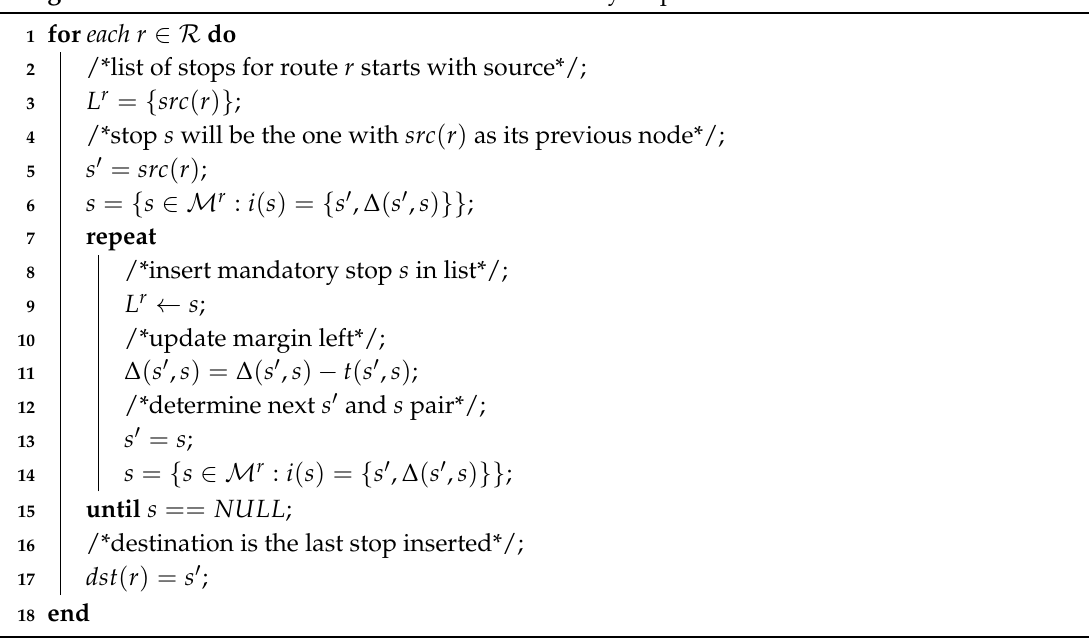
Algorithm 1: Procedure for the insertion of mandatory